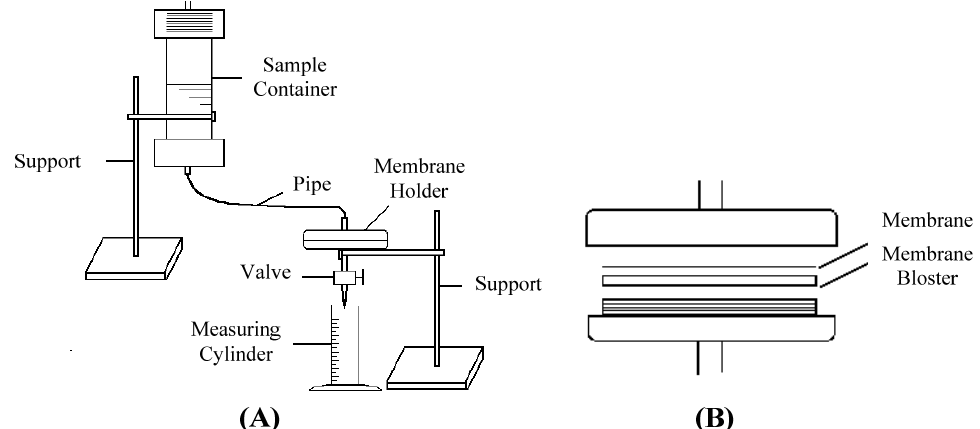
Figure 1. Schematic diagram of filtration device: ( A ) set for membrane blocking; ( B ) membrane holder.